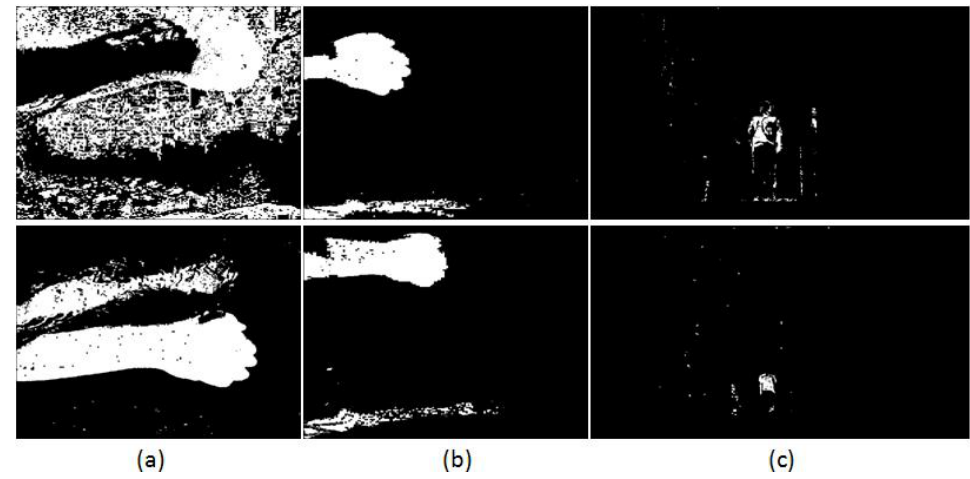
Figure 16. Samples of simulation results for the method by Varcheie et al . ( a ) Video 1 ( b ) Video 4 ( c ) Video